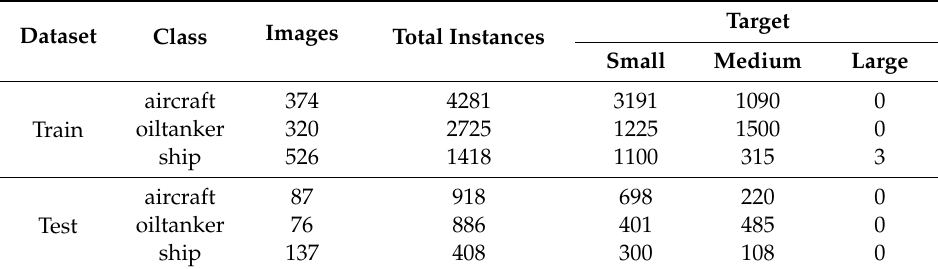
Table 1. The remote sensing image dataset.